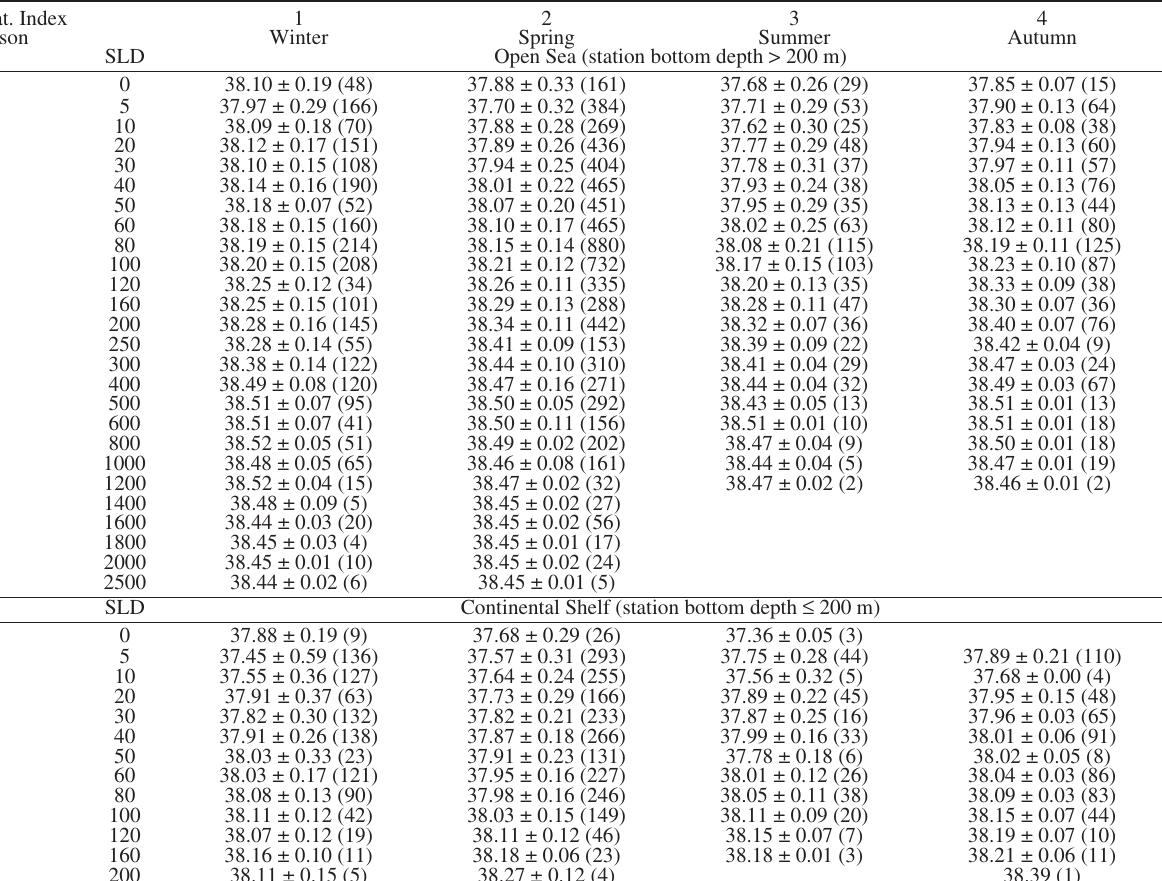
Table S9. – Salinity with depth and stratification of the water column in the Catalan Sea (NW Mediterranean Sea). Shown are average ± standard deviation (number of data between parentheses). SL, Standard Level; SLD, Standard Level Depth (m). Strat.